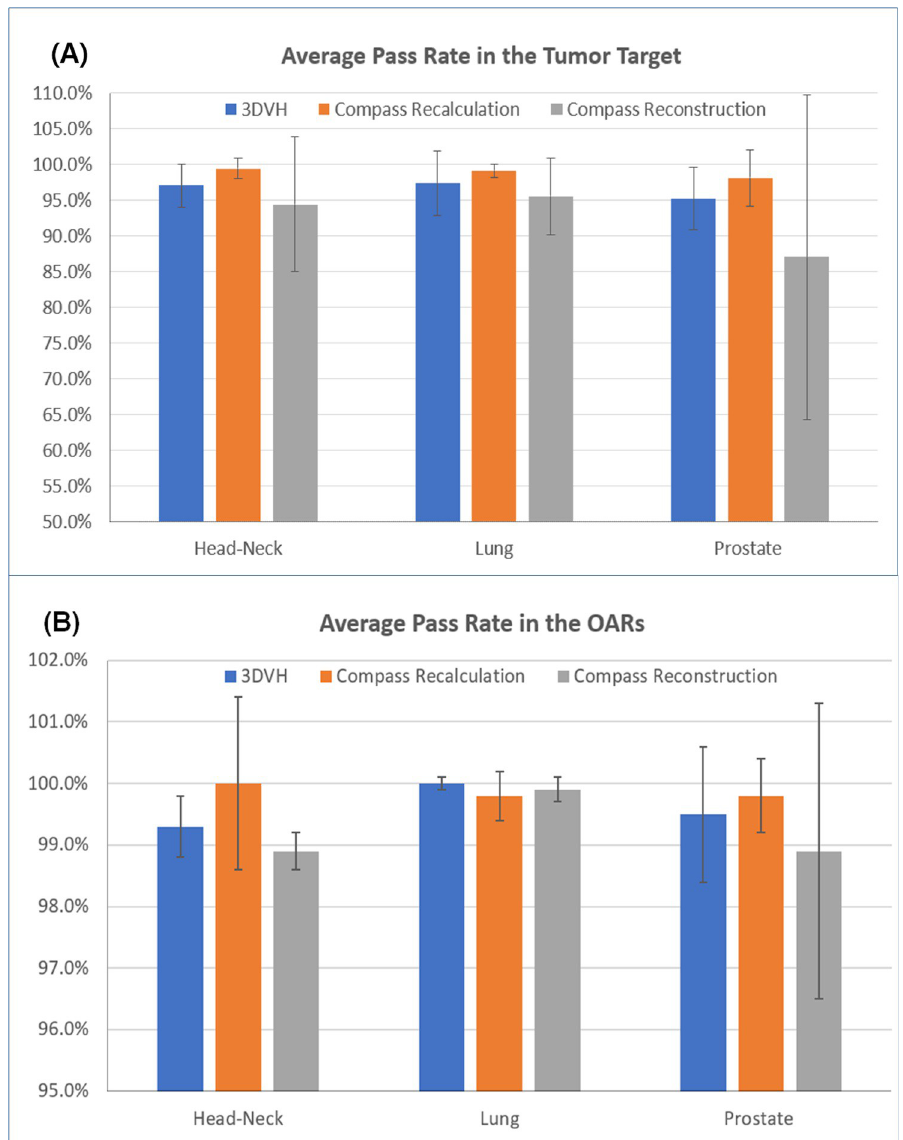
Fig 7. Comparison of the pass rate calculated in a gamma evaluation between a reference dose calculated using Eclipse TPS and a calculated dose using 3DVH and compass. (A) average pass rate in the tumor target, (B) average pass rate in the